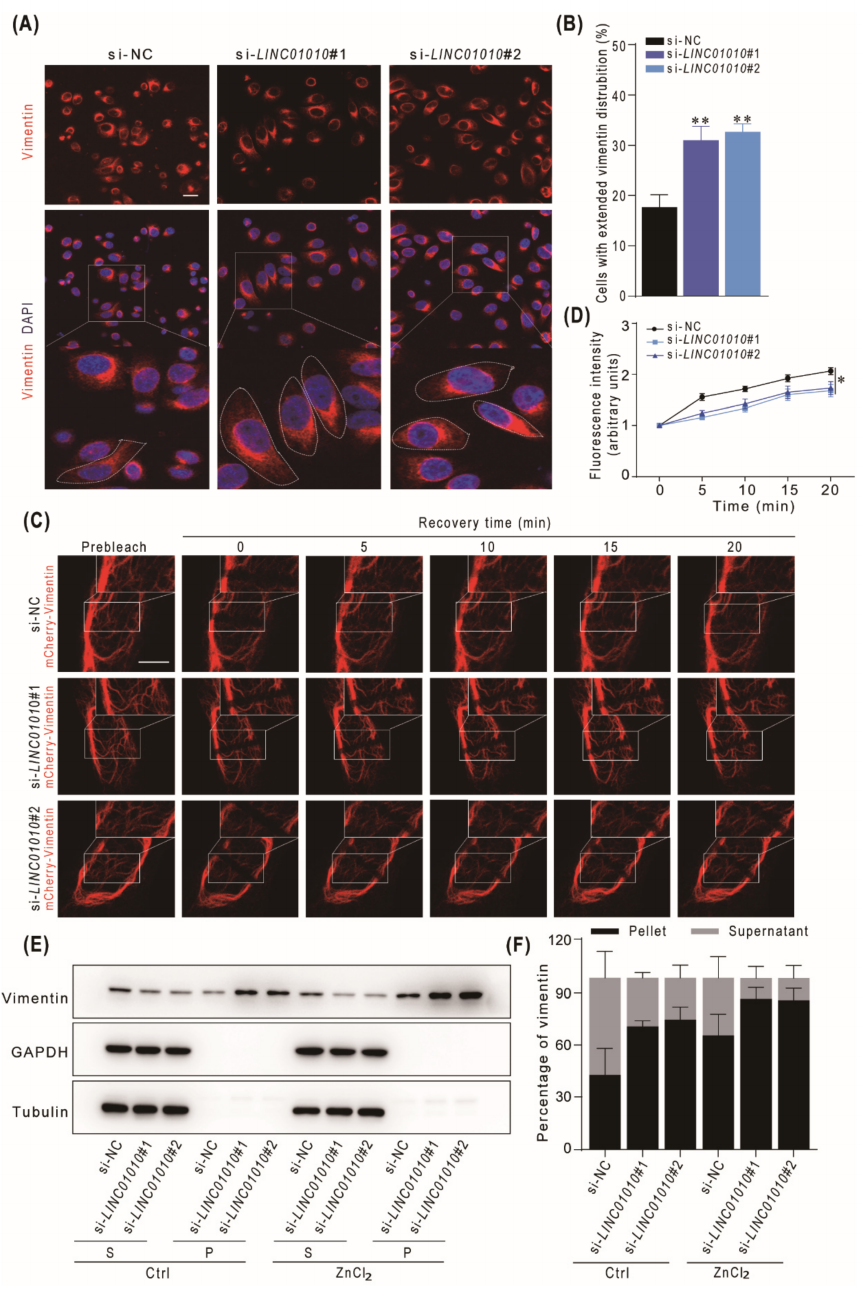
Figure 5. Knockdown of LINC01010 enhances the stability and formation of vimentin network. ( A , B ) HepG2 cells were transfected with LINC01010 siRNAs or control siRNA for 48 h and then plated on cover glass for 4 h and subjected to immunofluorescence assays with vimentin antibodies. Red fluorescence (vimentin),DAPI staining (nuclei). The white dotted line indicates the cells with extended vimentin. Scale bars, 25 µ m ( A ). The numbers of extended cells were quantified ( B ). ( C , D ) HepG2 cells were transfected with LINC01010 siRNAs or control siRNA for 24 h and then transfected with mCherry-vimentin. Then the cells were photo-bleached, and fluorescence recovery was monitored by acquiring images at time of 5, 10, 15 and 20 min after photo-bleaching with Leica SP8 confocal microscope, the white square indicates the photo-bleaching regions. Scale bars, 10 µ m ( C ). The fluorescence intensity of the bleached region at the different time points after quenching was measured by ImageJ software (si-NC, n = 10; si- LINC01010 #1, n = 10 si- LINC01010 #2, n = 10) ( D ). ( E , F ) HepG2 cells were transfected with LINC01010 siRNAs or control siRNA, the cells were treated with or without ZnCl 2 (30 µ M) for 12 h. Then the cell lysates were harvested and fractionated into supernatant (S) and pellet (P) and subjected to immunoblotting analysis. The relative density of vimentin was calculated ( E ). The percentage of soluble and insoluble vimentin was measured ( F ). * p < 0.05 and ** p < 0.01, means ± SD are